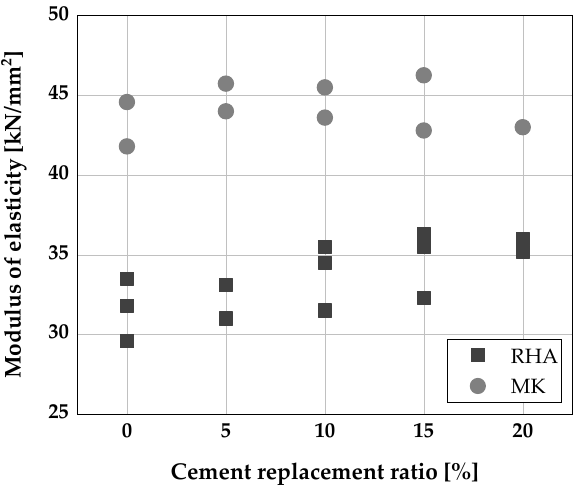
Figure 7. Modulus of elasticity: Molaeiraisi [116] , He [117] , Ramezanianpour et al. [118] , Barkat et al. [22] , Johari [119].